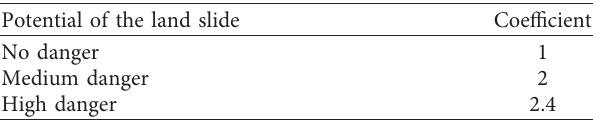
Table 9: Weighted coefficient for the land slide potential CS.